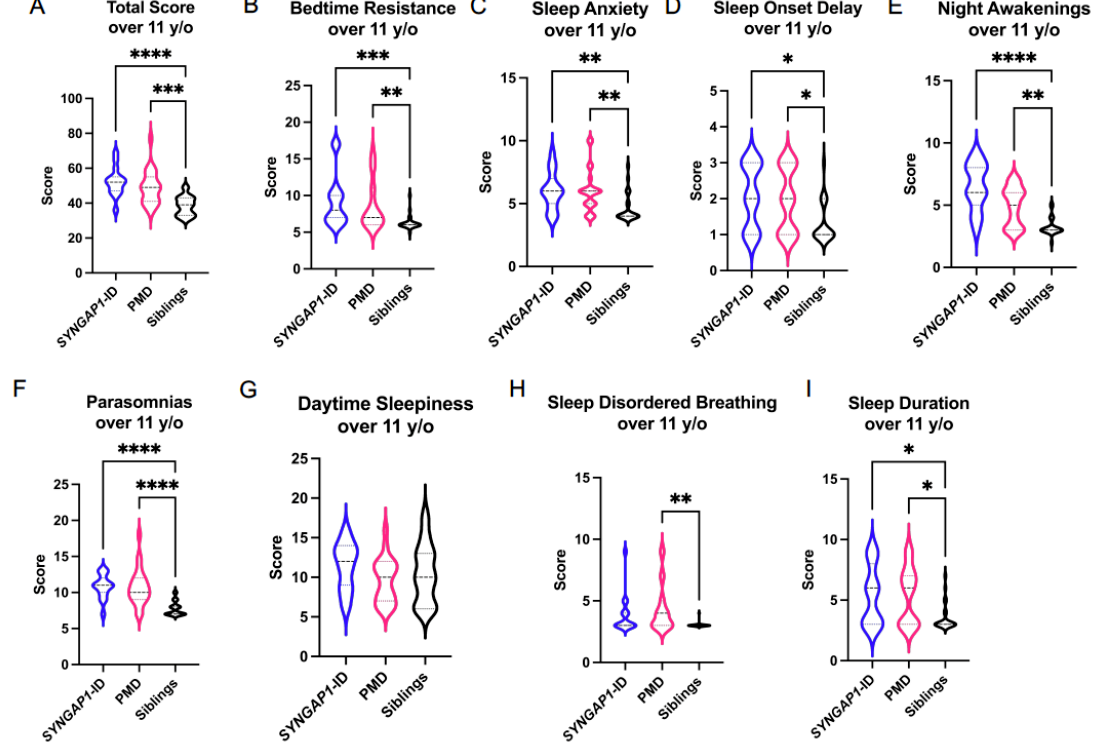
Figure 3. Total ( A ) and sub-scale scores for SYNGAP1 -related intellectual disability ( SYNGAP1 -ID), Phelan–McDermid syndrome (PMD) and unaffected siblings (Siblings) 11 years of age and older. Sub-scales: ( B ) Bedtime Resistance, ( C ) Sleep Anxiety, ( D ) Sleep Onset Delay, ( E ) Night Awakenings, ( F ) Parasomnias, ( G ) Daytime Sleepiness, ( H ) Sleep Disordered Breathing, ( I ) Sleep Duration. Dunn’s multiple comparisons test * p < 0.05, ** p < 0.01, *** p < 0.001, **** p < 0.0001. Heavy dashed line is median, light dashed line is quartile. Table 4. CSHQ data 11 years and older, mean (standard deviation).